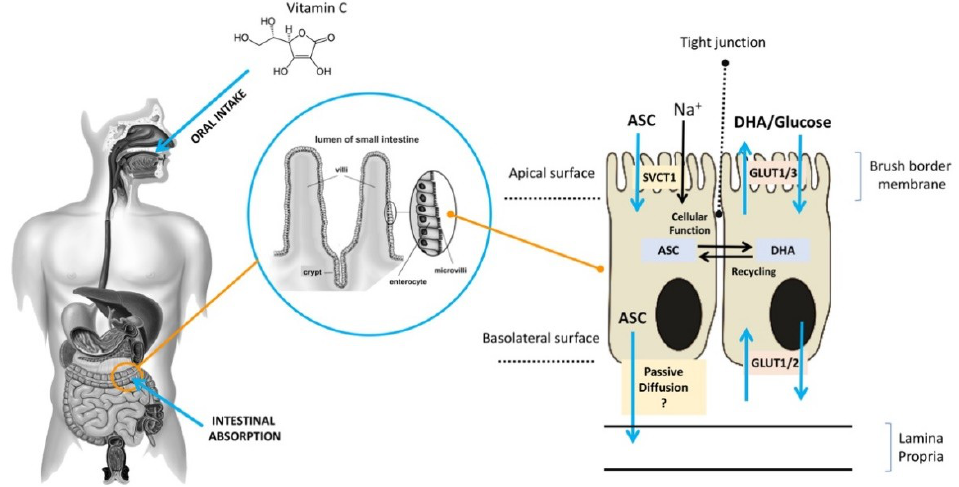
Figure 2. Absorption of ASC across the brush border membrane in intestinal epithelial cells (ASC: ascorbic acid;DHA: dehydroascorbic acid;SVCT: sodium–ASC co-transporters;GLUT: glucose transporters).